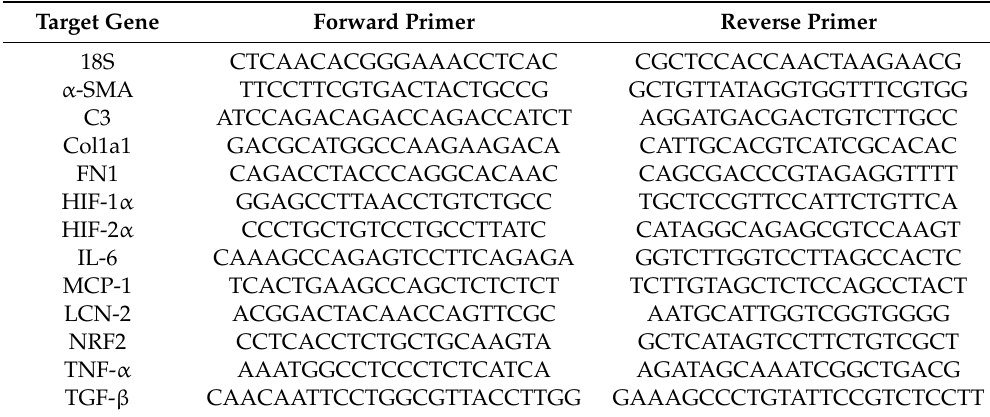
Table 2. The primers applied for